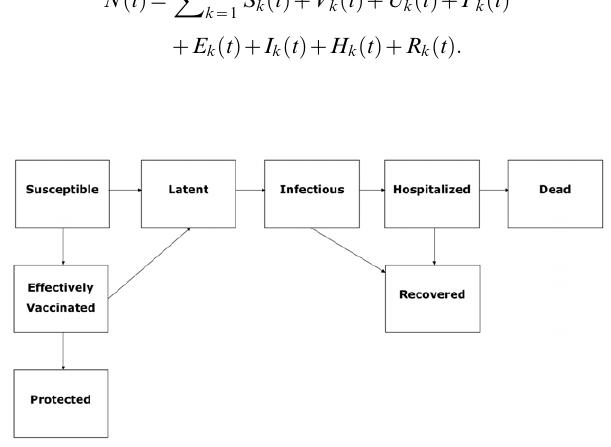
Figure 1. Flow chart of the stage progression of the individuals among the different epidemiological